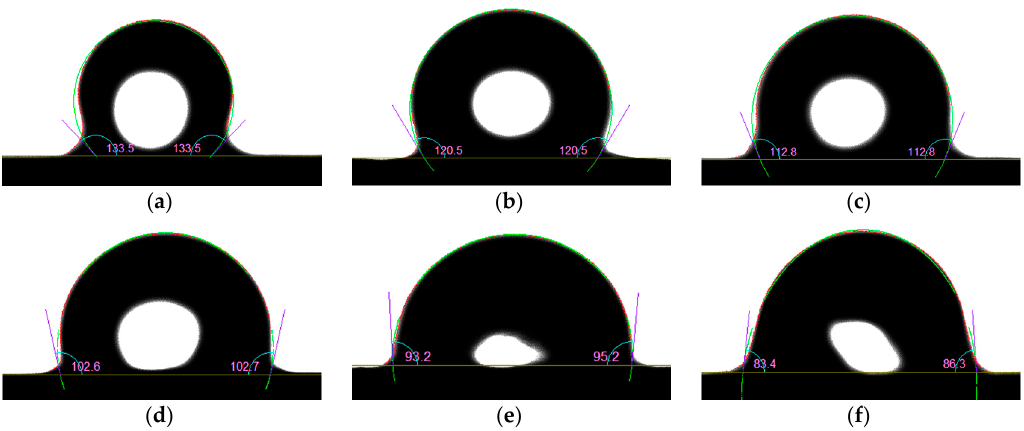
Figure 3. Static contact angle of samples under different years: ( a ) A 1 ; ( b ) A 2 ; ( c ) A 3 ; ( d ) A 4 ; ( e ) A 5 ; ( f ) A 6 .